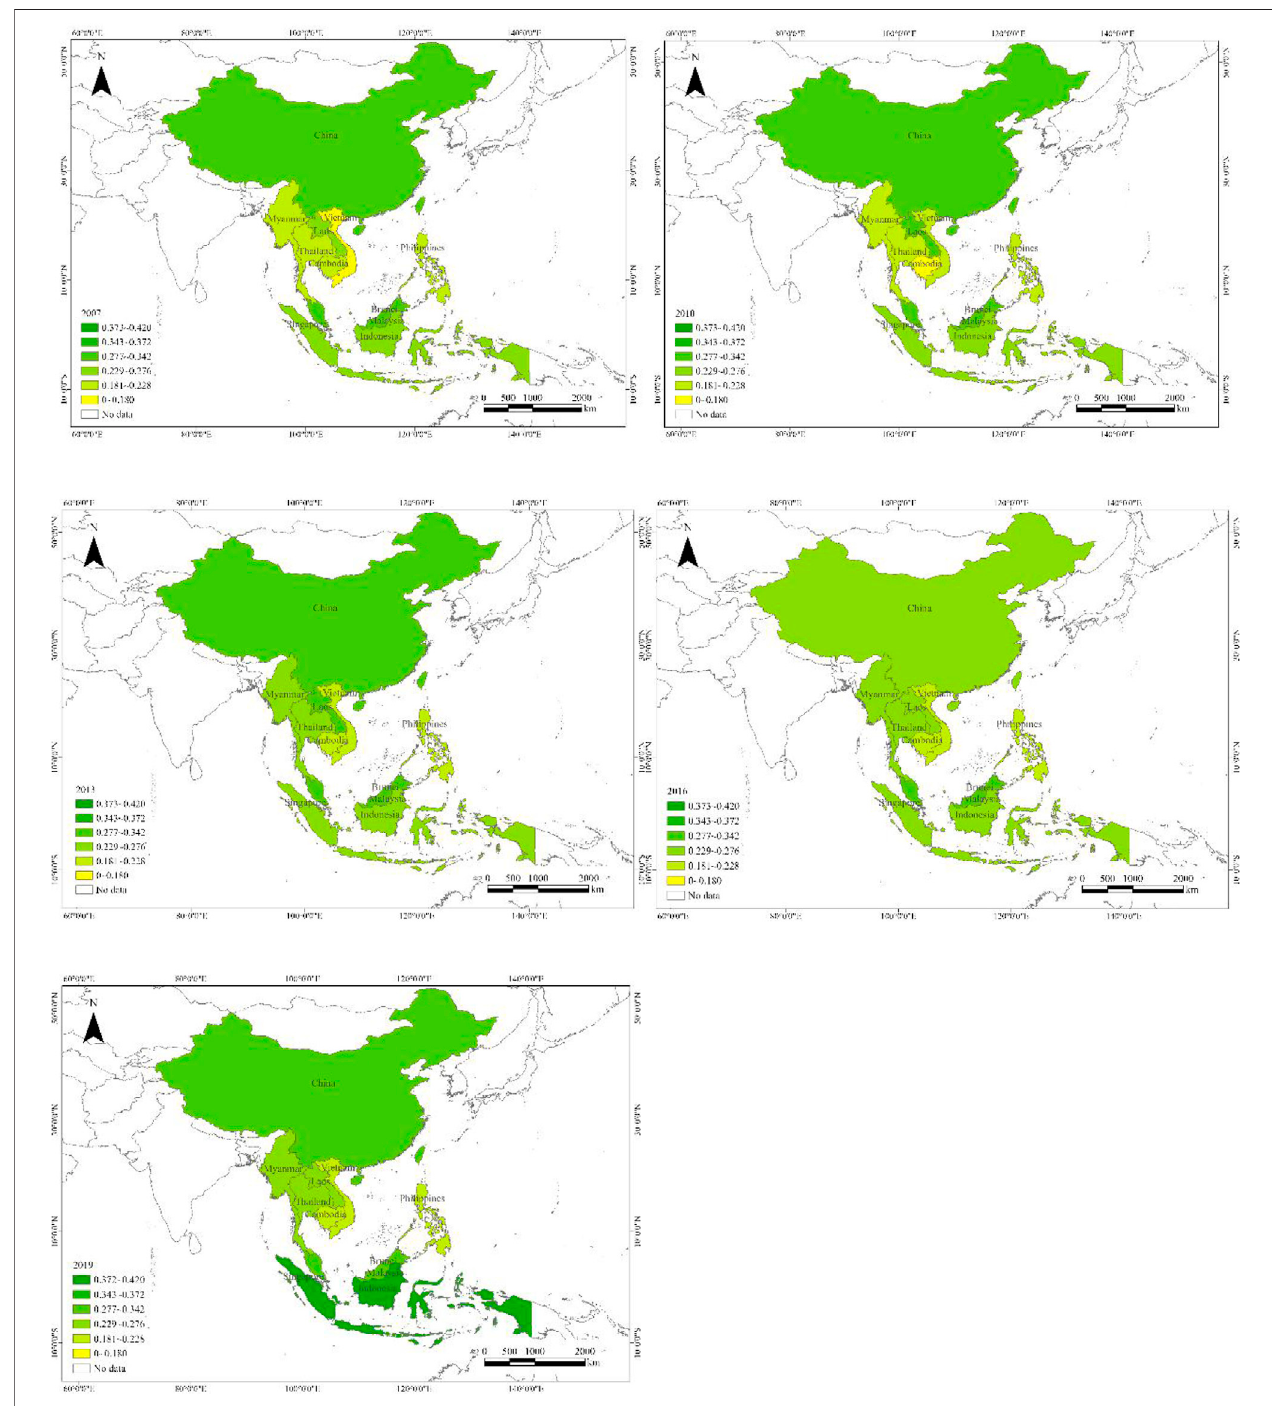
FIGURE 6 | Spatial distribution of economic-social-natural complex ecosystem in the CAFTA countries (2007 – 2019). The complex ecosystem index values were derived from Supplementary Appendix Table S1 .